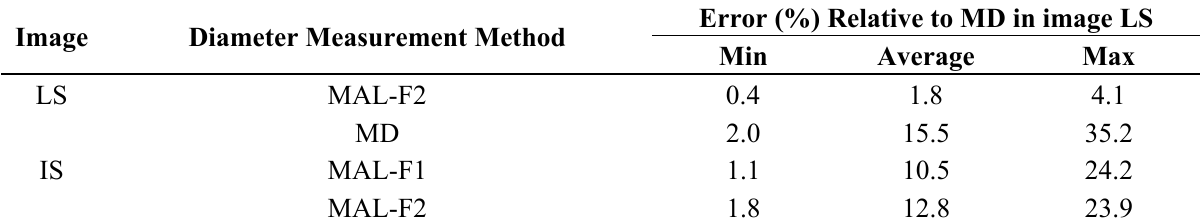
Table 7. Relative error in the estimate of fruit diameter: occlusion ratio higher than 66%.